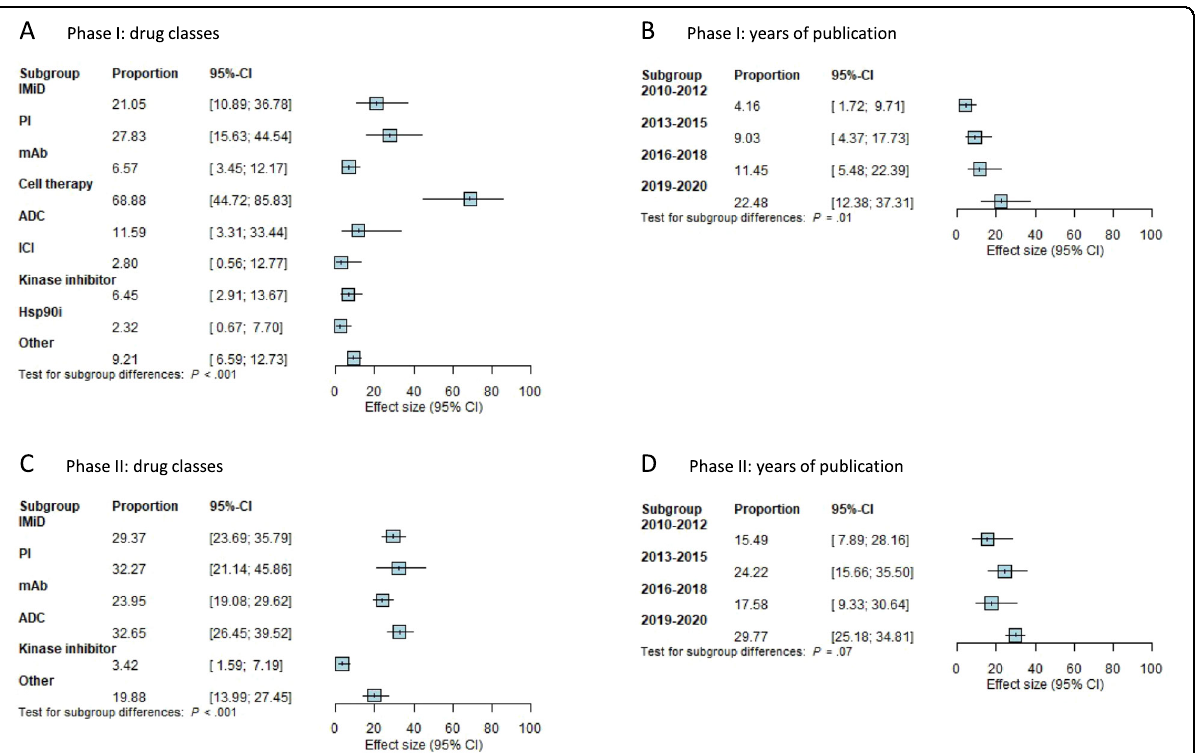
Fig. 4 Estimates of overall response rates for subgroups. A Overall response rates in phase I trials by drug class. B Overall response rates in phase I trials by years of publication. C Overall response rates in phase II trials by drug class. D Overall response rates in phase II trials by years of publication. Squares represent estimate values. Horizontal lines through the squares indicate 95% CIs. IMiD immunomodulatory imide drugs, PI proteasome inhibitors, mAb monoclonal antibodies, ADC antibody – drug conjugate, ICI immune checkpoint inhibitor, Hsp90i heat-shock protein